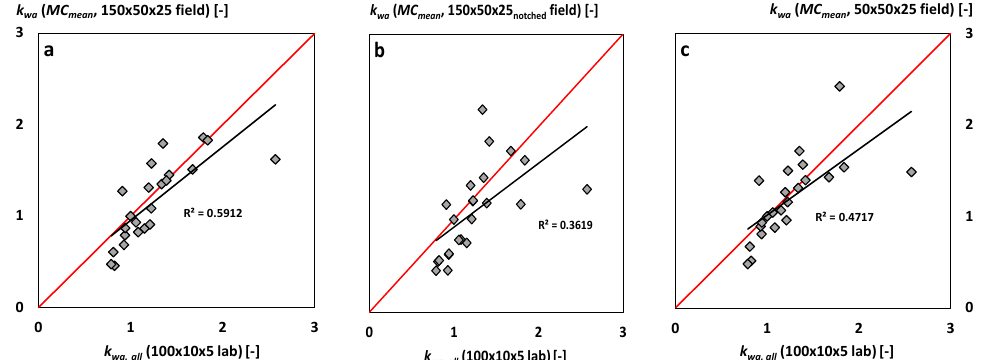
Figure 13. k wa factors based on MC mean (%) of test specimens of 150 (ax.) × 50 × 25 mm 3 without notch ( a ) and with a notch ( b ) and of 50 (ax.) × 50 × 25 mm 3 ( c ) determined during outside exposure versus k wa , all factors of 100 (ax.) × 10 × 5 mm 3 specimens determined during 24 h water uptake and release tests according to [3].